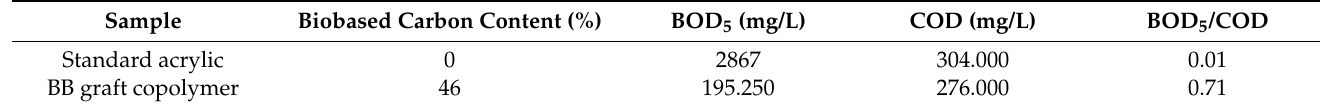
Table 4. Biobased carbon content, COD, BOD 5 and biodegradability of the products studied.